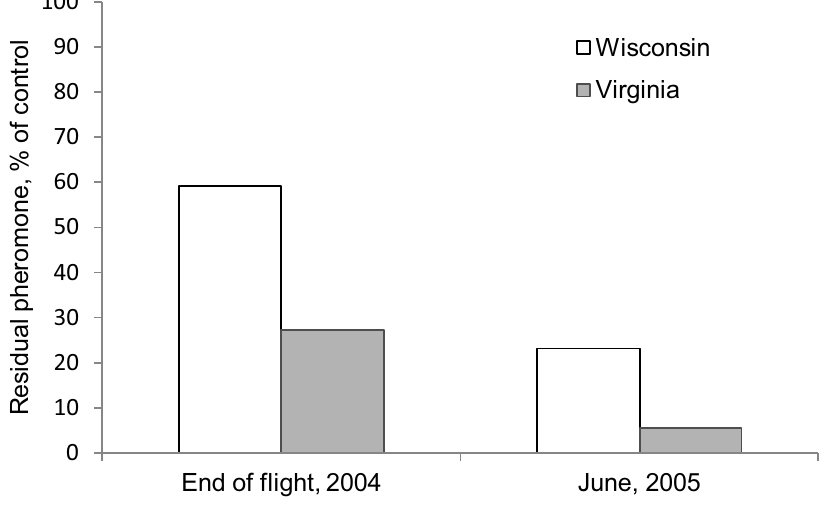
Figure 2. Residual amount of pheromone left in Hercon Disrupt® II plastic flakes after 10 weeks of exposure during the summer flight period and in the following year in VA and WI. The residual amounts of disparlure are shown as percentages based on control